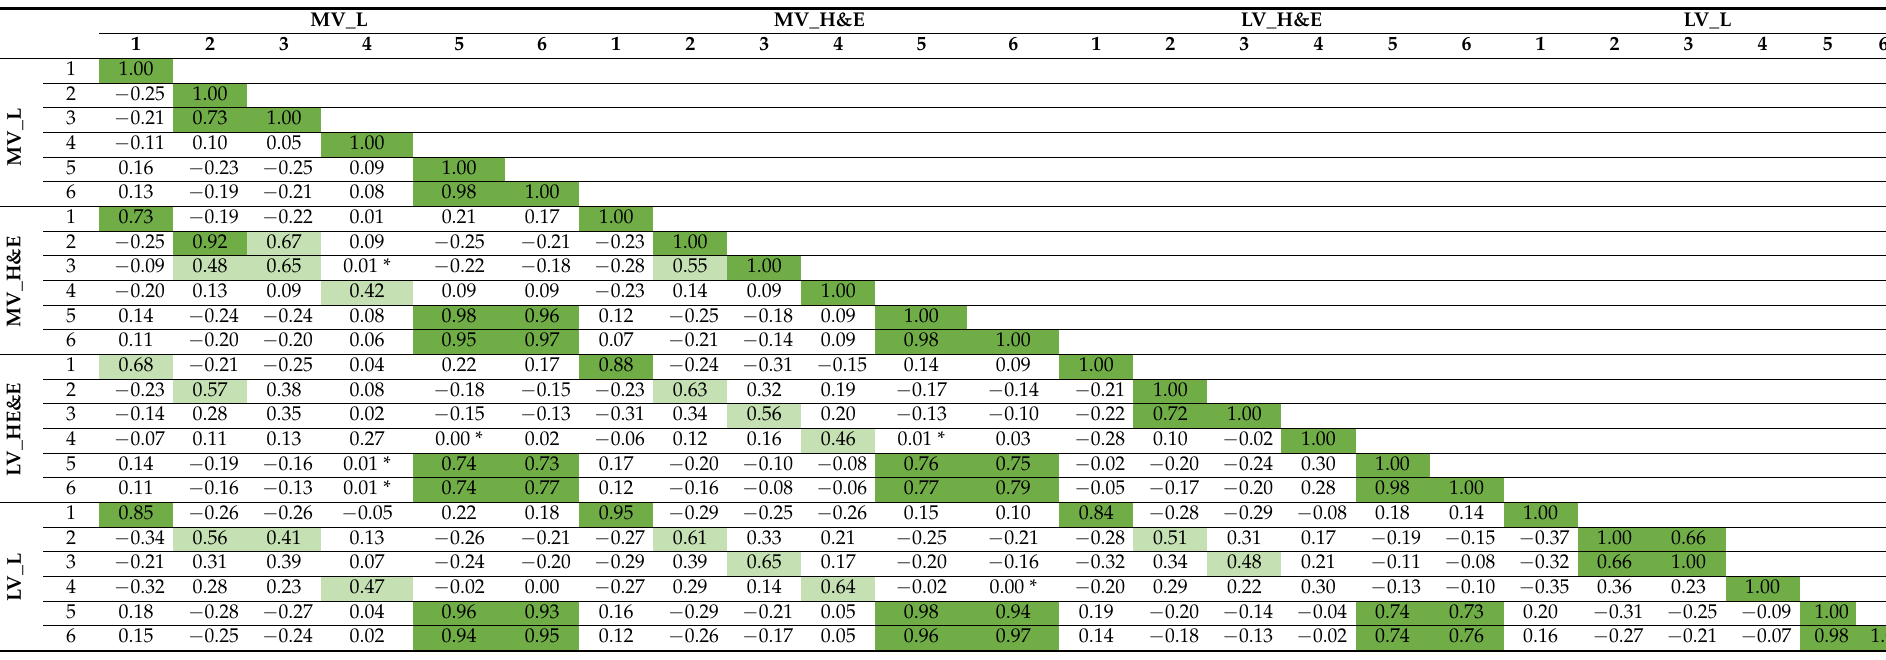
Table 5. Correlation using the Spearman coefficient between global indicators for the investigated measurement points in the